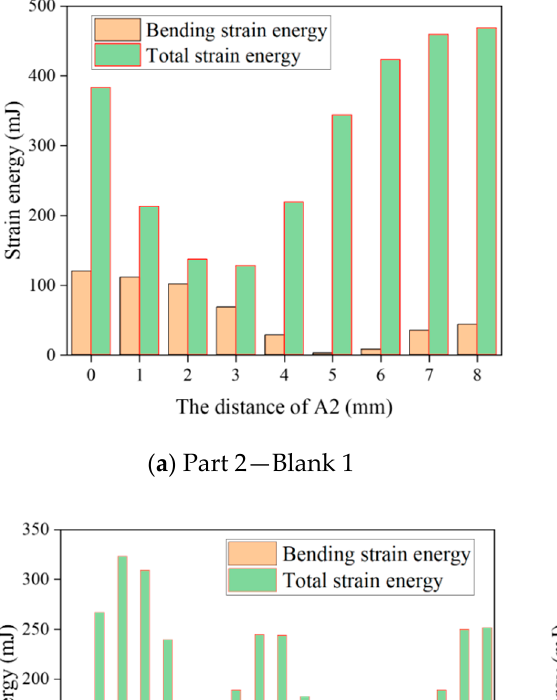
Table 3. The theoretical minimum distortion and the corresponding part position. Part